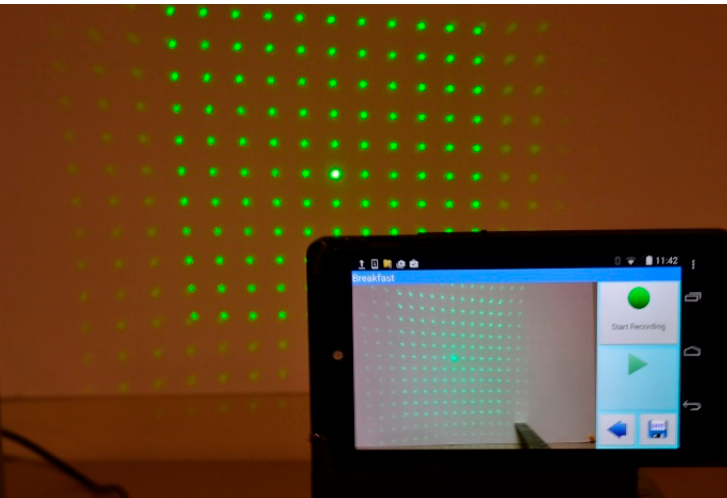
Figure 8. The calibration process of the DDRS consists of taking multiple snapshots of the projected laser grid onto a white flat surface at 1 cm increments from 60 cm to 10 cm. This process is only done once and allows the algorithm to have comprehensive data on pixel distance to true depth ratio, which will be used to calculate the volume.